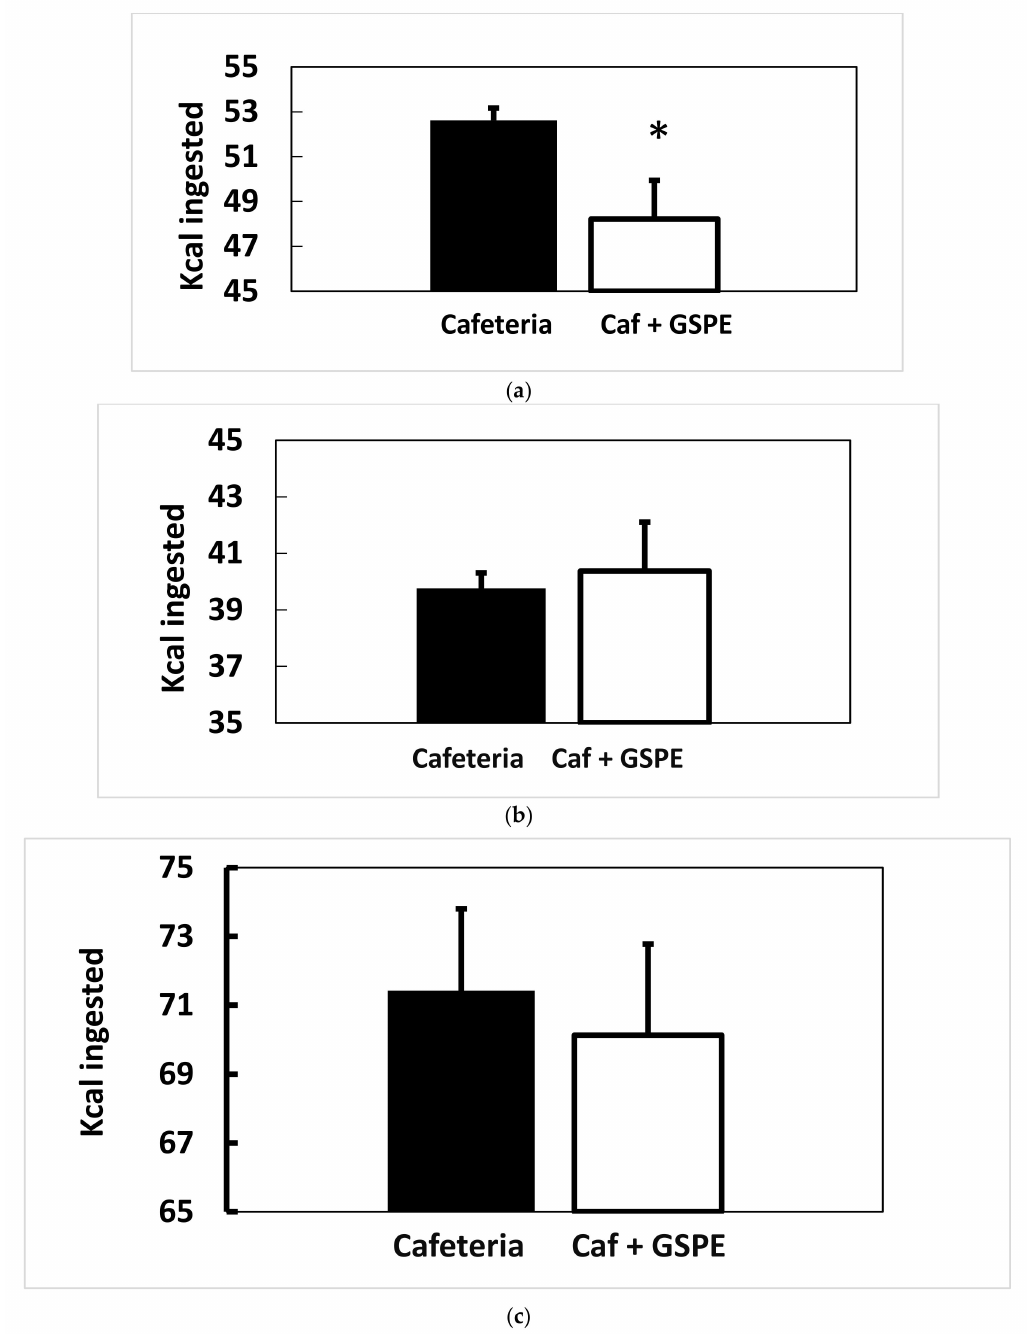
Figure 1. Food intake in the short-cafeteria study in di ff erent diet periods. Food intake was measured 20 h after the daily food had been replaced for each diet administered. The black column indicates animals not treated with grape seed proanthocyanidin extract (GSPE). The white column indicates animals treated with 0.5 g / Kg BW of GSPE for the first 10 days of treatment. The results showed the mean data obtained from each measurement throughout the period. ( a ) Mean food intake from the daily measurement for the first ten days of treatment with a tasty diet. ( b ) Mean food intake from measurements taken during the eighteen days of treatment with a chow diet. ( c ) Mean food intake from measurements during the thirty-five days with a cafeteria diet. Statistical di ff erences identified by t -test are defined by * when p < 0.05 between